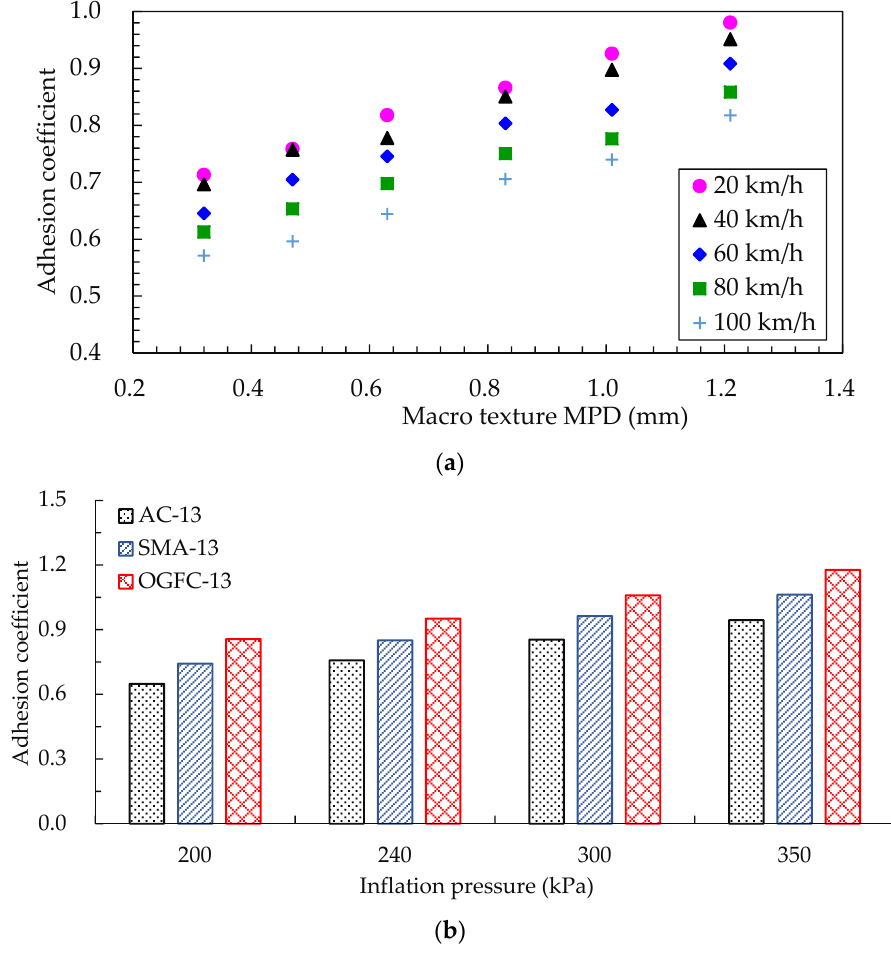
Figure 9. Influencing factors of adhesion coefficient in a dry road state: ( a ) influence of macro texture on adhesion coefficient; ( b ) influence of inflation pressure on adhesion coefficient.